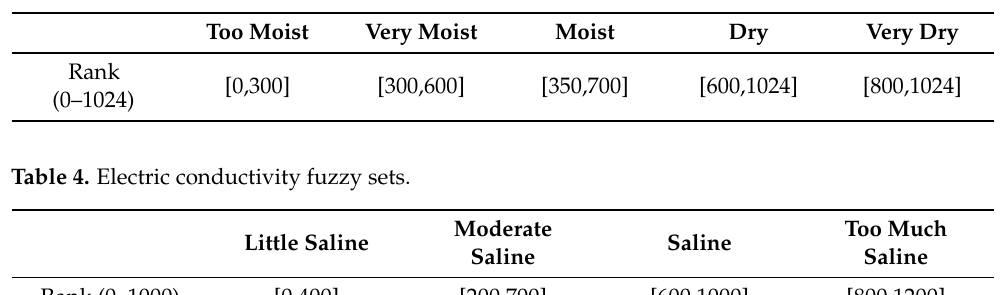
Table 3. Substrate humidity fuzzy sets.